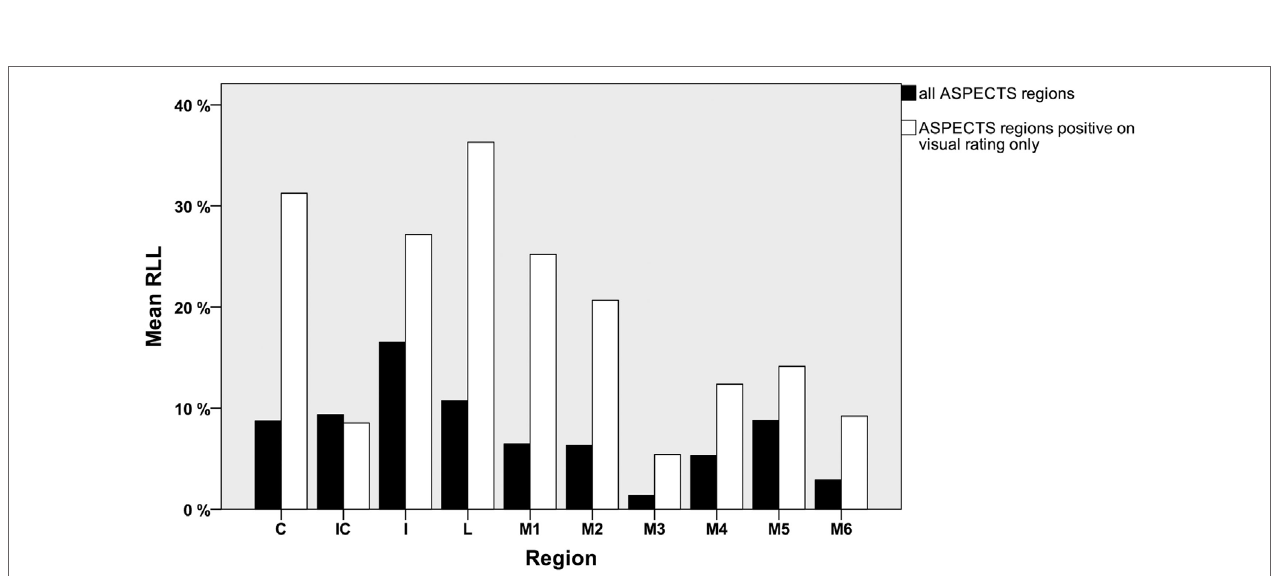
FigUre 1 | Distribution of ischemic voxels in standard Montreal Neurologic Institute space for all patients studied, displayed as a heat map indicating the number of patients with ischemia in the respective voxel. Only patients with unilateral lesions were included in the study.